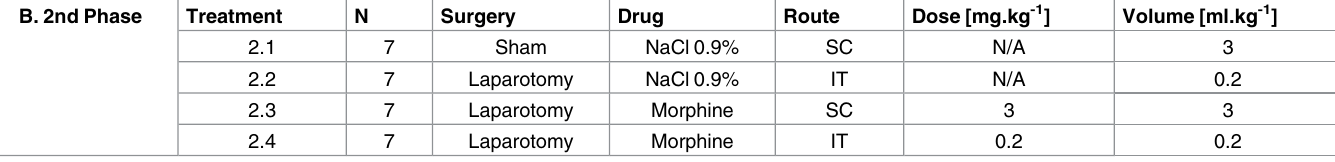
Table 2. Treatment groups in phase 2 of the study. B. 2nd